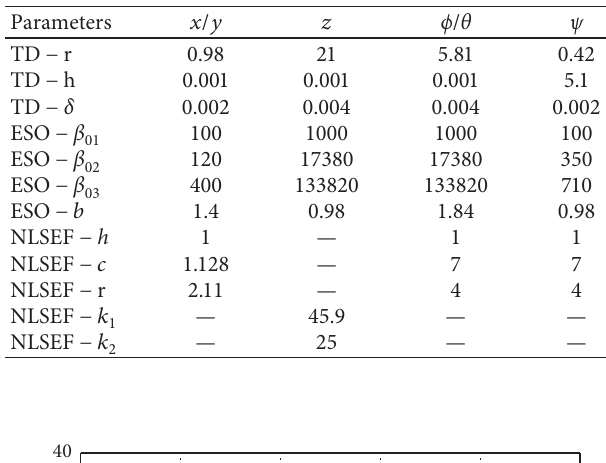
Table 3: Simulation parameters of active disturbance rejection flight controller.